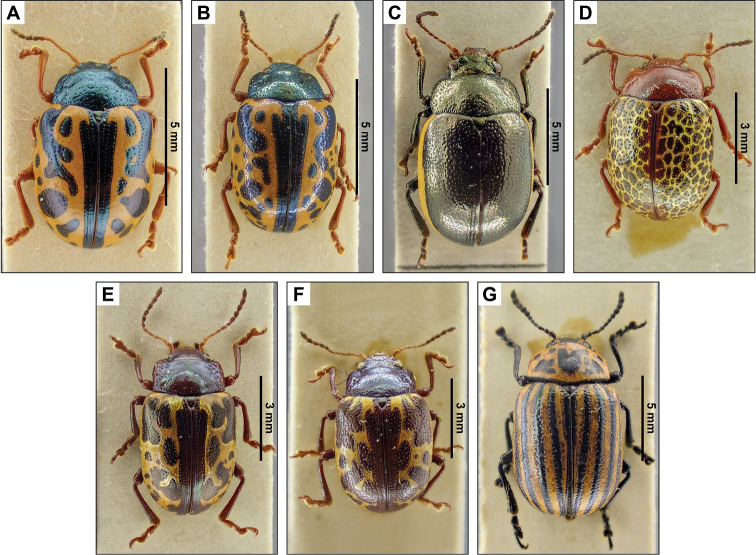
Dorsal pictures of the species of Chrysomelinae from El Salvador currently present in the collections of the RBINS. ACalligraphabajulaBC.fulvipesCC. (Zygospila) championiDC. (Zygospila) guttulosaEC. (Zygospila) piceicollisFC. (Zygospila) signatipennisGLeptinotarsaundecimlineata. High resolution images can be found at http://collections.naturalsciences.be/ssh-entomology.